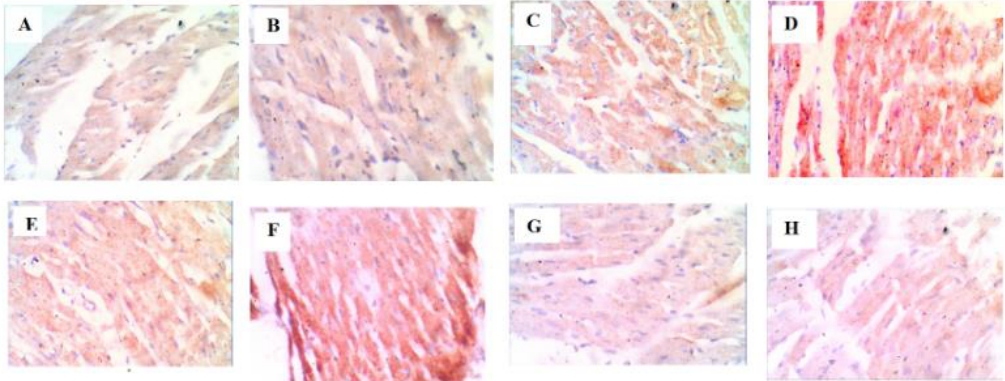
Fig. 2. Immunohistochemical cytoplasmic staining of Bax. A: Control (7 days)/weak staining; B: Control (14 days)/weak staining; C: Irradiated (14 days)/moderate staining; D: Irradiated (14 days)/strong staining; E: Ectoine treated (7 days)/moderate staining; F: Ectoine treated (14 days)/strong staining; G: Ectoine plus irradiation (7 days) showing weak cytoplasmic staining. H: Ectoine plus irradiation (14 days) showing weak cytoplasmic staining